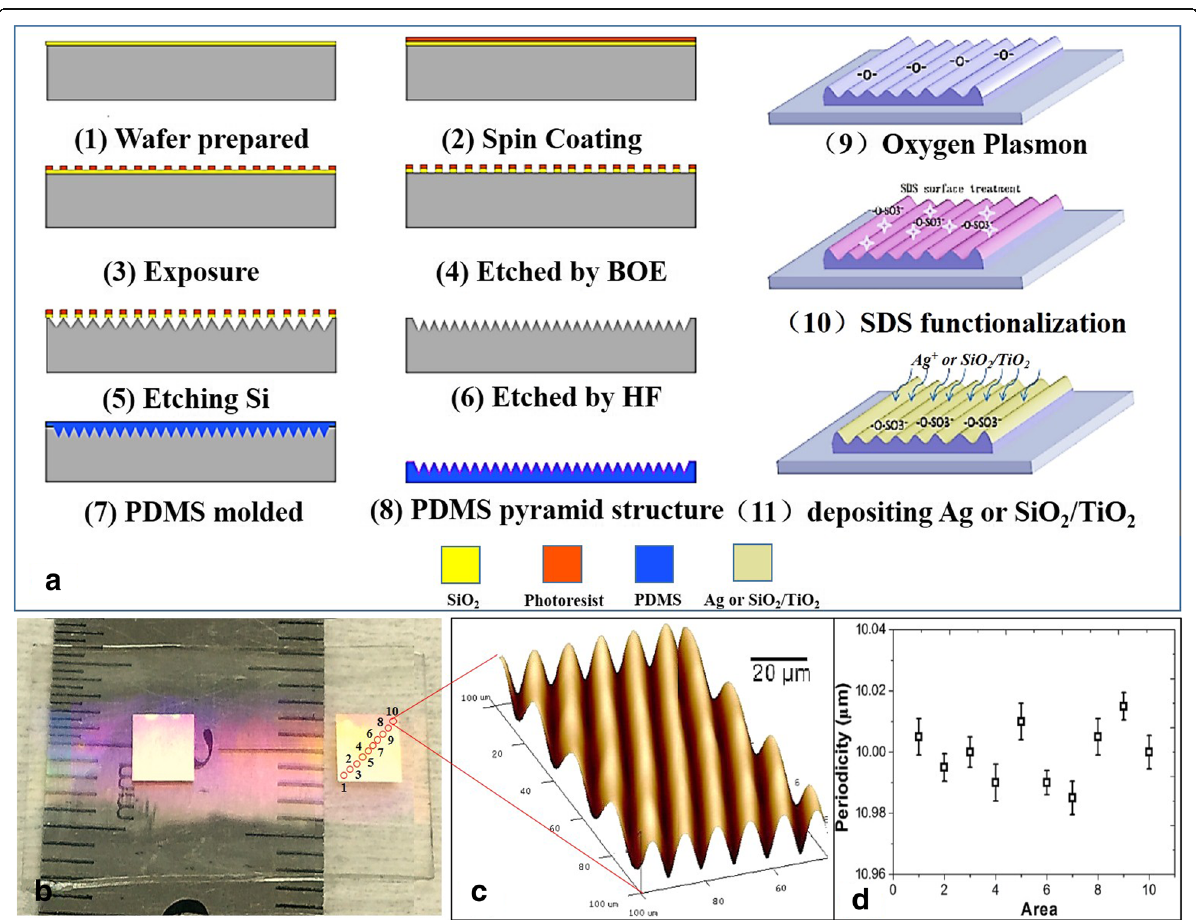
Fig. 2 Fabrication process and morphology characterization of the triangular wrinkle structures on the polydimethylsiloxane (PDMS) substrates. a Fabrication process of the Ag (SiO 2 /TiO 2 )-embedded triangular wrinkle structures. b Optical image. c AFM image. d The uniformity of periodicity for the